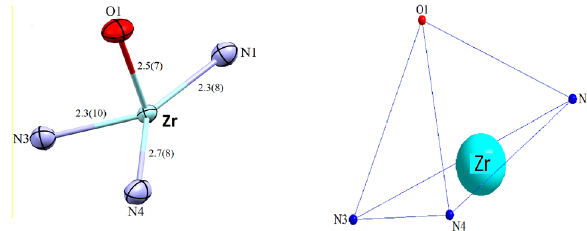
Figure 9: Coordination mode of the complex ( 2 ) : [